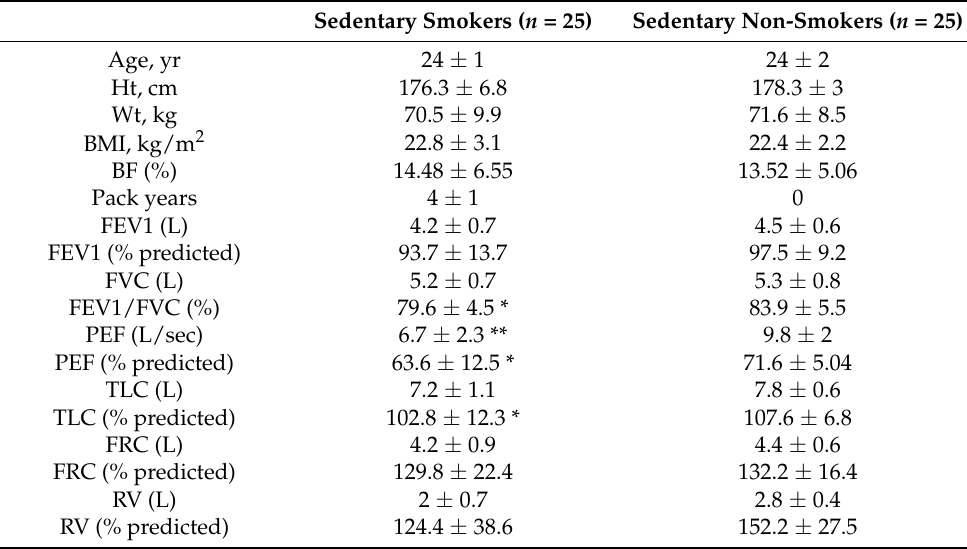
Table 1. Baseline anthropometric characteristics and pulmonary function tests values in sedentary smokers and non-smokers. Sedentary Smokers ( n = 25) Sedentary Non-Smokers ( n = 25) Age,